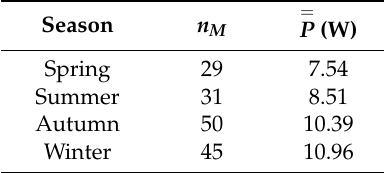
Table 3. Potential for power generation divided by seasons of the year.